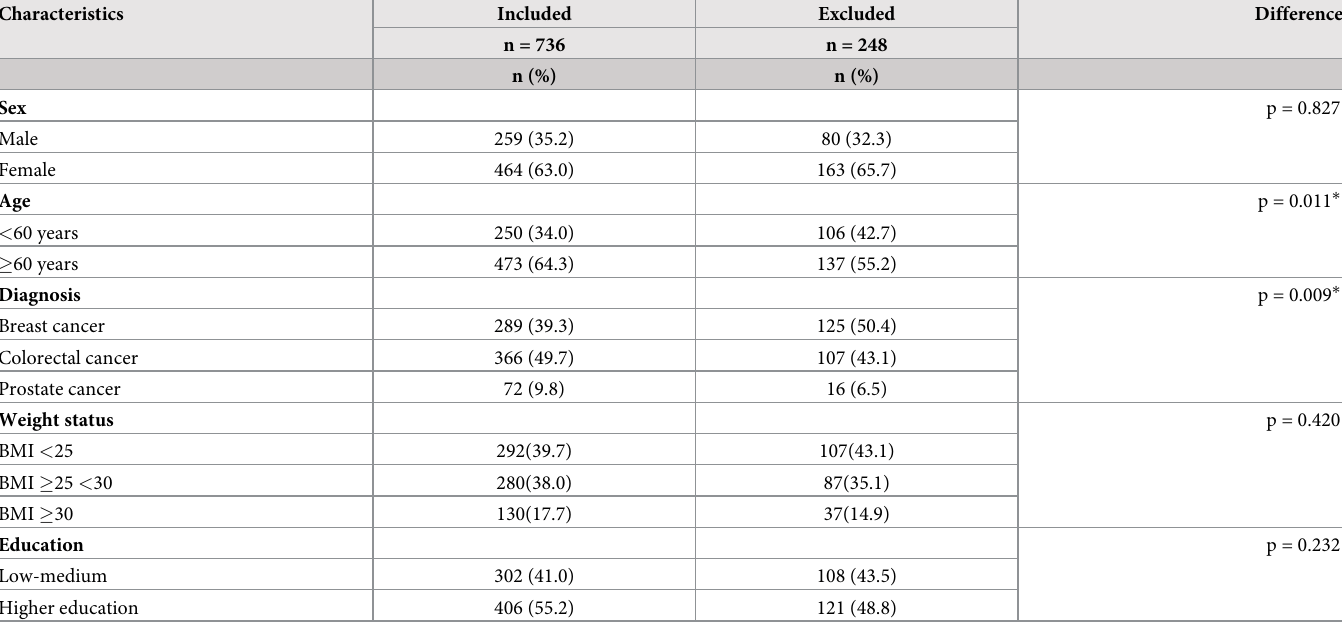
Table 1. Descriptive statistics of cancer survivors with six valid measuring days (included) and without six valid days (excluded).